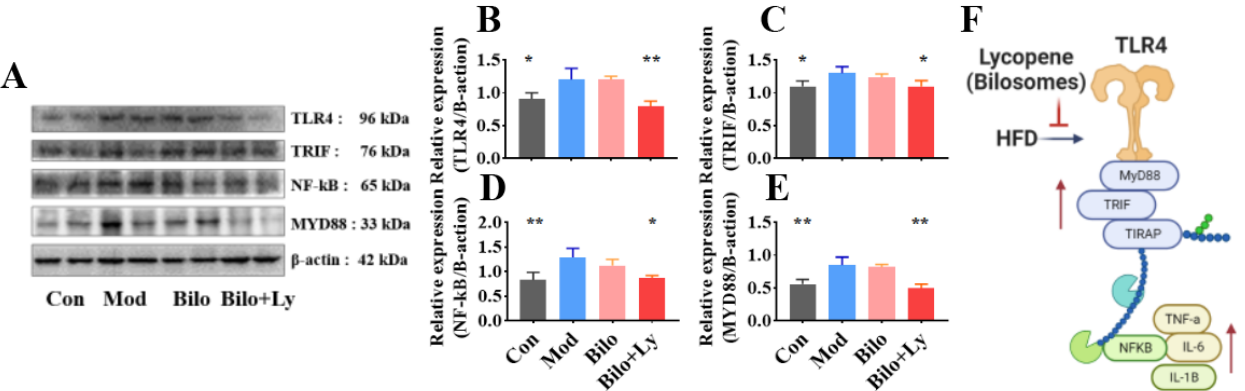
Figure 5. Effect of lycopene on protein expression levels of TLR4/MyD88 pathway. Signaling molecule expression, including TLR4, TRIF, MyD88, and NF- κ B ( A ). The expression level of TLR4 in mouse kidney ( B ). The expression level of TRIF in mouse kidney ( C ). Expression levels of NF-kB in mouse kidneys ( D ). The expression level of MyD88 in mouse kidney ( E ). TLR4 pathway effect map ( F ). Signs of significant differences between the Mod group and other groups: * p < 0.05, ** p < 0.01.